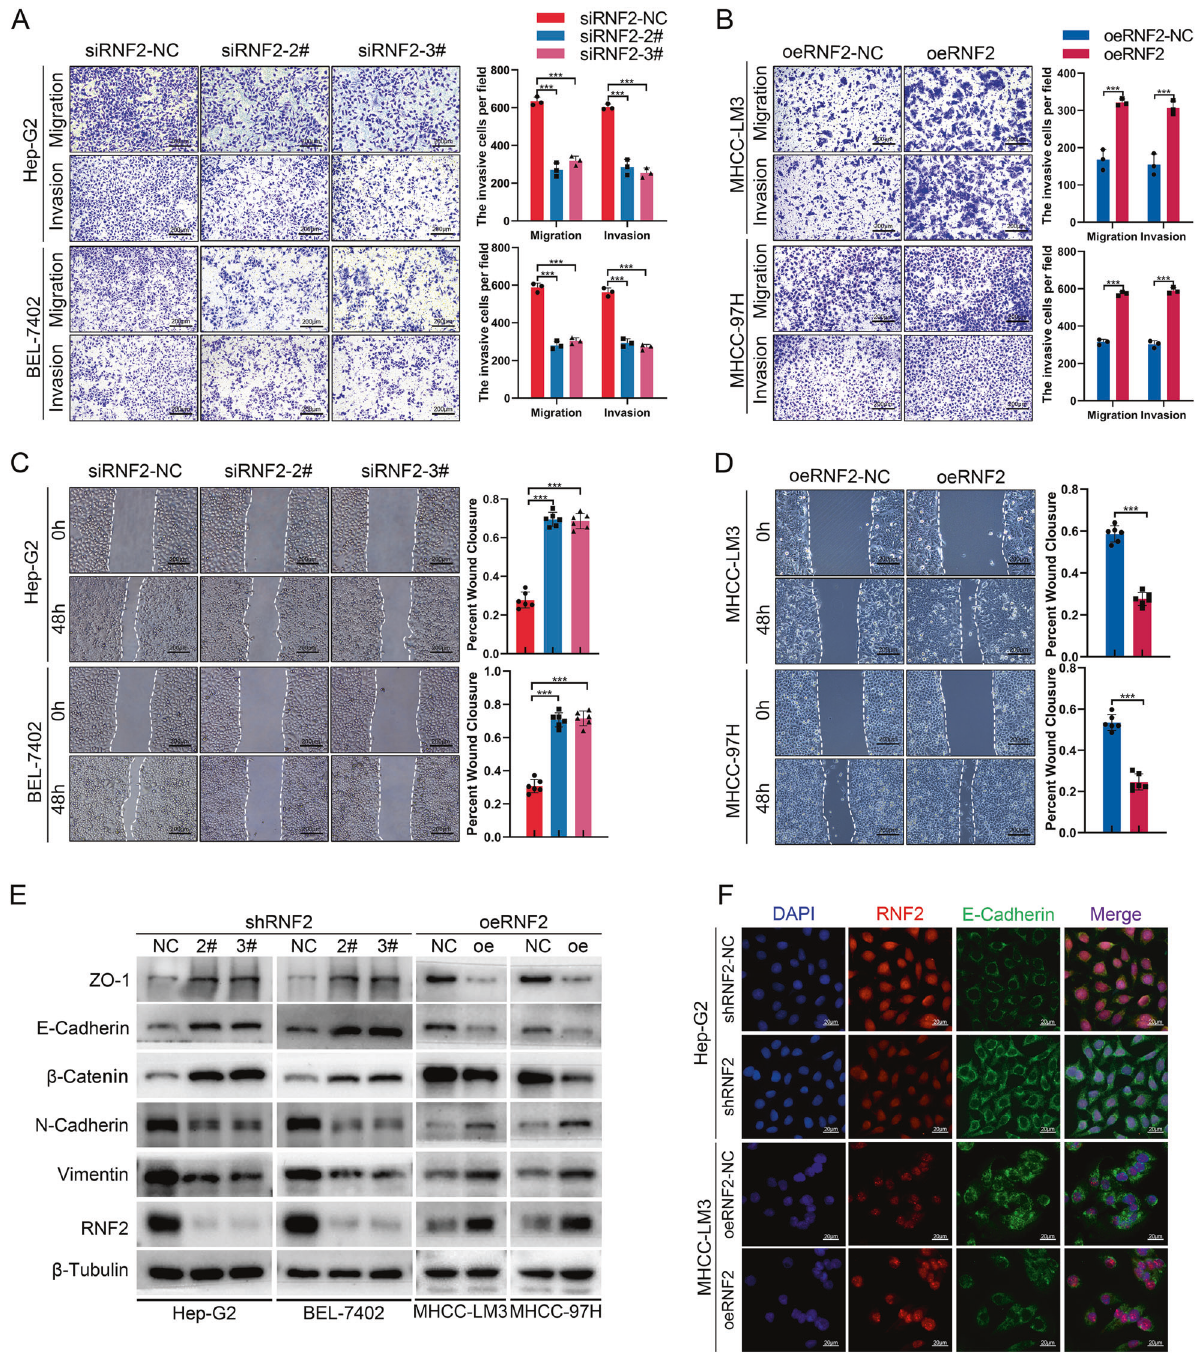
Fig. 3 RNF2 promotes invasion and migration of HCC via enhancing EMT. A , B Representative images and quantitative analysis of the Transwell assay for transfected Hep-G2/BEL-7402/MHCC-LM3/MHCC-97H cells. C , D Representative images and quantitative analysis of the Wound healing assay for transfected Hep-G2/BEL-7402/MHCC-LM3/MHCC-97H cells. E Western blot assay results of protein level of EMT related molecules after silencing or overexpressing RNF2 in HCC cell lines. F Immuno fl uorescence (IF) images of the effect on E-Cadherin expression after knockdown of RNF2 in Hep-G2 cells or overexpression of RNF2 in MHCC-LM3 cells. Scale bar, 20 μ m. expressed in HCC and was associated with malignant clinical cancer cells suppresses RNF2 and MAPK-related cisplatin resis- features and poor prognosis (Fig. 1). Moreover, in vitro, transwell tance. [39] Simultaneous silencing of Ring1A and Ring1B results in assays and wound healing assays con fi rmed that the expression low levels of H2AK119ub modi fi cation, which inhibits Snail- levels of RNF2 were positively correlated with invasion and mediated metastasis of pancreatic cancer cells. [26] Moreover, migration of HCC cells (Fig. 3). Furthermore, RNF2 could promote under chronic glucose stress conditions, RNF2 degrades HRIP via lung metastasis and bone metastasis of HCC cells in vivo (Fig. 6). the ubiquitin proteasome pathway leading to apoptosis in breast Our study explored the expression pattern and prognostic value of cancer cells. [6] In present study, we found that RNF2 was highly Cell Death and Disease (2023)